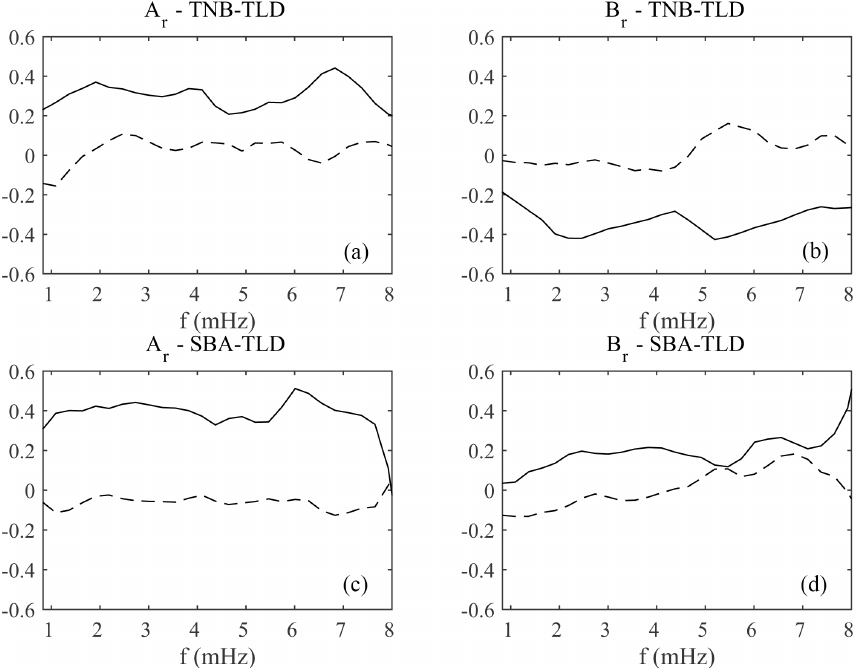
Figure 6. Remote reference transfer functions A r and B r at TNB (a, b) and SBA (c, d) ; solid and dotted lines indicate the real and imaginary parts,